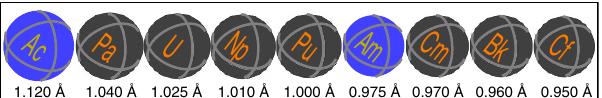
Figure 5 | Ionic radii of the early to mid-actinides. Scheme showing the ionic radii (Å) of trivalent actinides from actinium to californium drawn to scale for six-coordinate ions 40 .